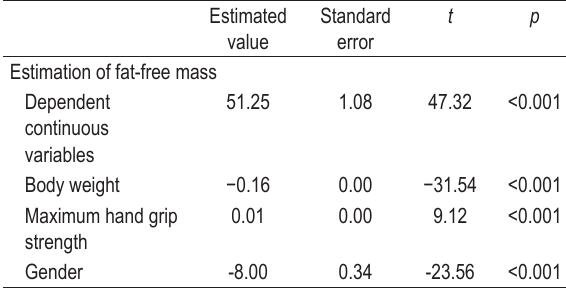
TABLE 4. Estimation of the fat-free mass percent using the values of body weight, maximum hand grip strength, and gender on the basis